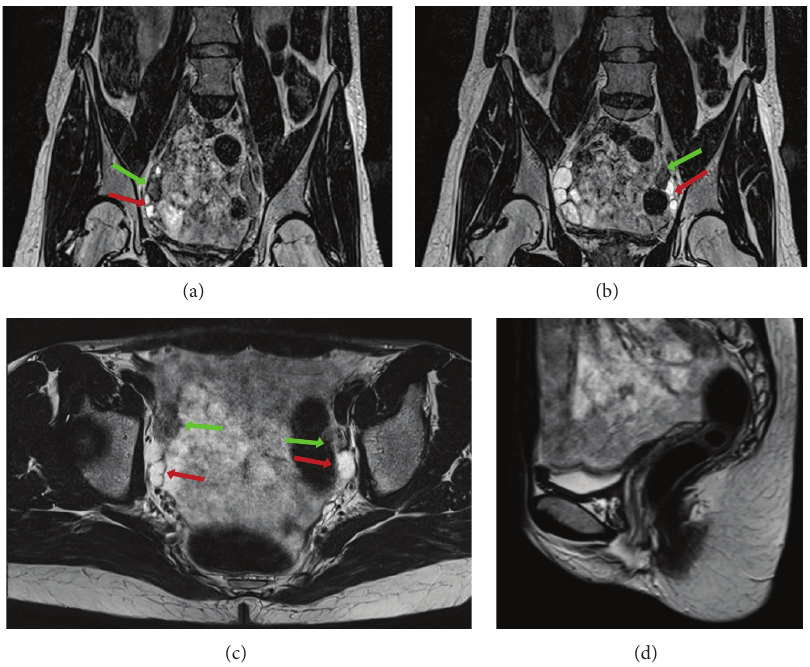
Figure 4: 38-year-old girl/female affected by CAIS. MRI T2-weighted coronal ((a) and (b)) and axial (c) images demonstrating the presence of the testes (green arrows) and adjoining cysts (red arrows). Sagittal T2 weighted image (d) showing agenesis of the M¨ullerian structures and presence of the lower third of the vagina (yellow arrowheads). (3T Magnetic Resonance Imaging. Coronal 1mm SPACE-sequence, TR/TE 1500/133; axial 4mm fast-T2-weighted image, TR/TE 4500/119; sagittal 5 mm HASTE-sequence, TR/TE 6500/89).